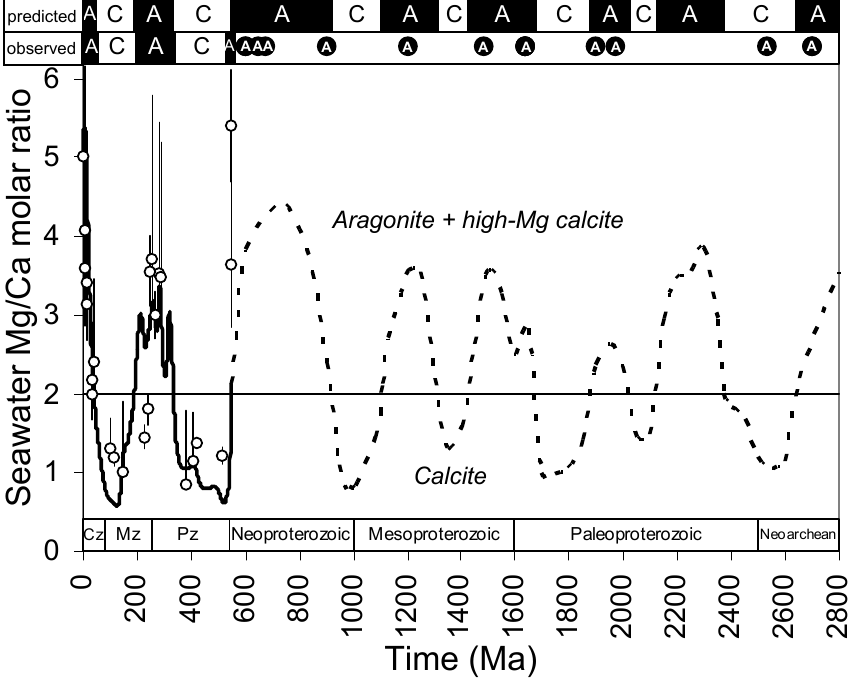
Fig. 26. Secular variation in Mg/Ca sw and the original polymorph mineralogy of nonskeletal CaCO 3 precipitates, including ooids, seafloor precipitates, and marine cements, since late Archean time (from Ries et al., 2008). Phanerozoic (solid curve; Hardie, 1996; Demicco et al., 2005) and Precambrian (dashed curve; Hardie, 2003) seawater Mg/Ca is calculated from hydrothermal brine-river water mixing models driven by rates of ocean crust production (Gaffin, 1987) and granite pluton data (Engel and Engel, 1970), respectively. Open circles correspond to Mg/Ca sw estimated from fluid inclusions in primary marine halite (Lowenstein et al., 2001, 2003, 2005; Brennan and Lowenstein, 2002; Brennan, 2002; Horita et al., 2002; Brennan et al., 2004; Timofeeff et al., 2006). Horizontal line divides the calcite (Mg/Ca sw < 2) and aragonite – high Mg calcite (Mg/Ca sw > 2) nucleation fields in seawater at 25 ◦ C (Leitmeier, 1910, 1915; Lippman, 1960; M¨uller et al., 1972; Berner, 1975; Given and Wilkinson, 1985; Stanley and Hardie, 1999). Temporal distribution of predicted (Hardie, 1996, 2003) and observed (Sandberg, 1983; Hardie, 2003) nonskeletal calcite (“C”) and aragonite (“A”) precipitates are plotted along top of figure. Closed black circles circumscribing “A” correspond to inferred aragonitic seafloor precipitates observed in Precambrian deposits (cf. Hardie,